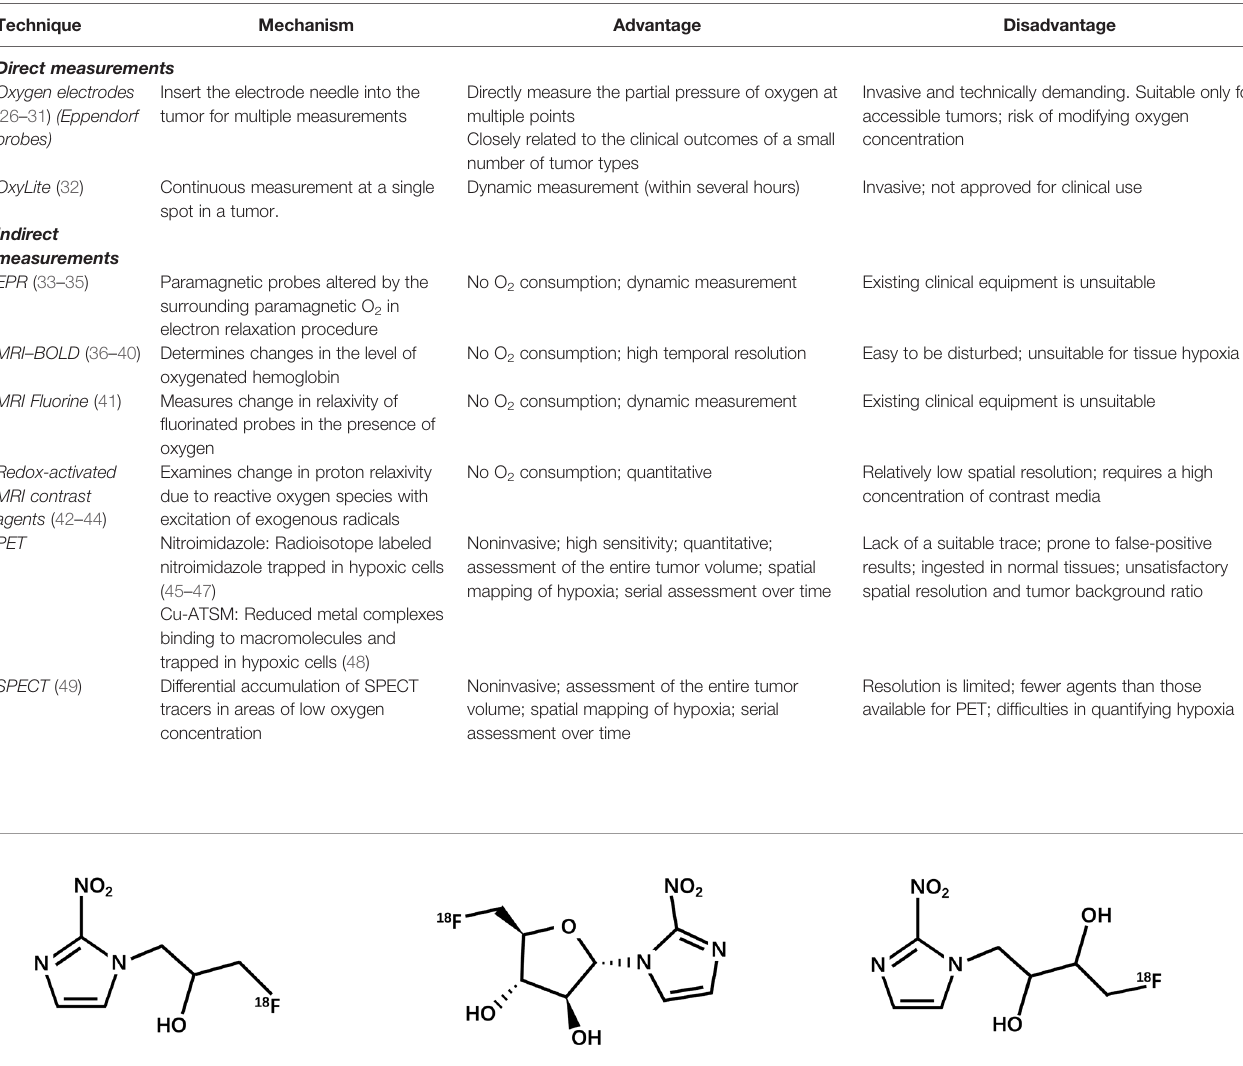
TABLE 1 | Main methods of hypoxia